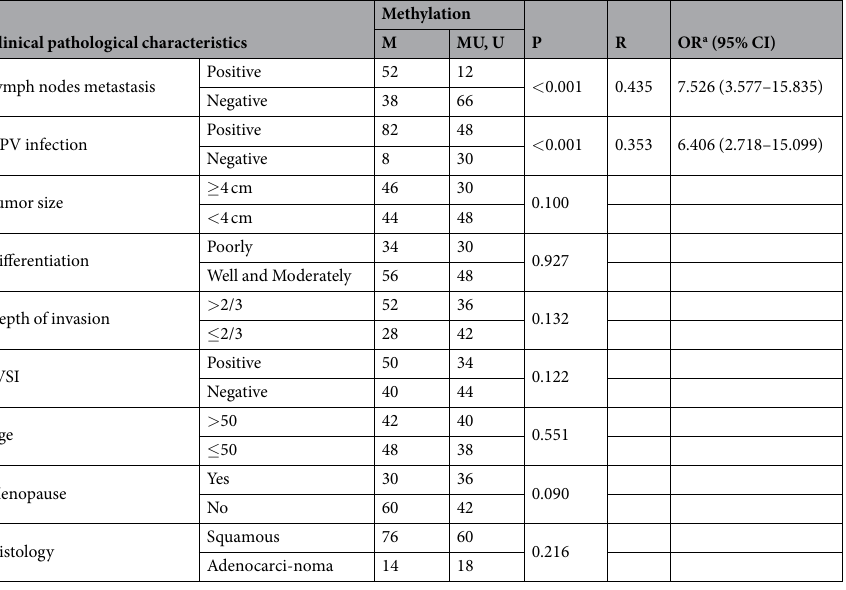
Table 2. Relationship between MEG3 methylation in plasma and clinical pathological characteristics. a OR (Odds